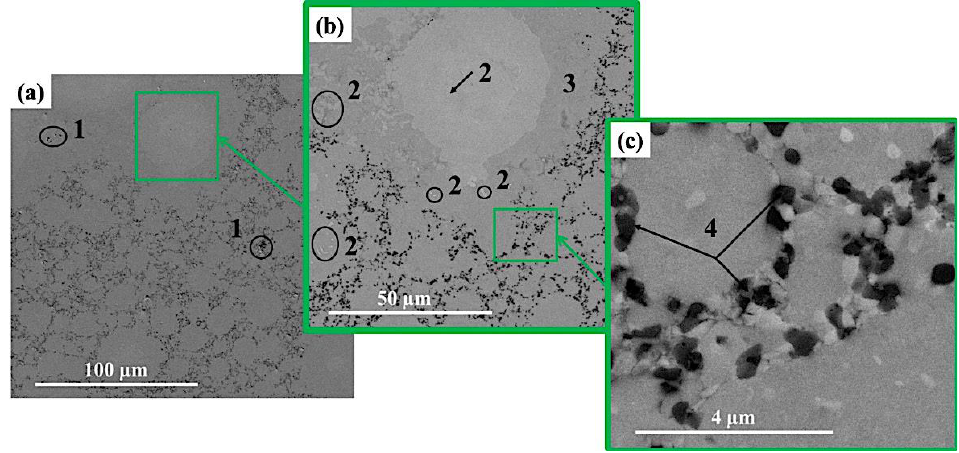
Figure 6. SEM image of the materials obtained by MEAM-HP with subsequent sintering at 1250 ± 20 °C: ×1400 ( a ),× 2800 ( b ) , × 41 400 ( c )